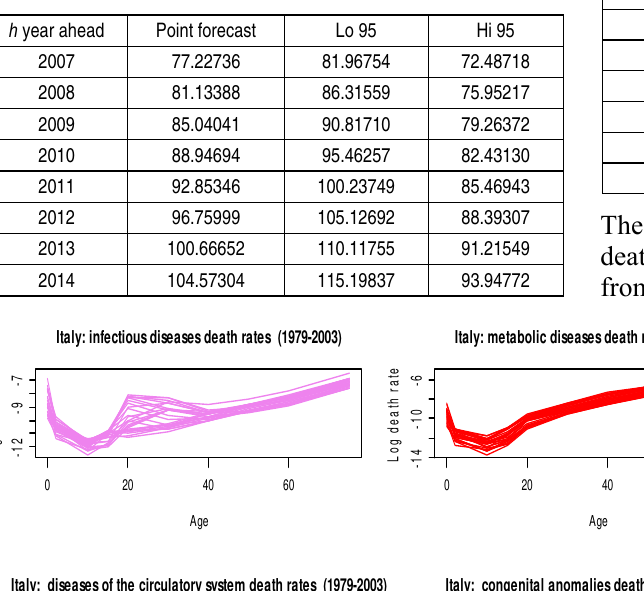
Table 1 shows the k prediction intervals for t h = 1,…, 20 periods ahead at level of 95%. Table 1. Confidence intervals for forecasted k – t aggregation by causes of death, Italian total population